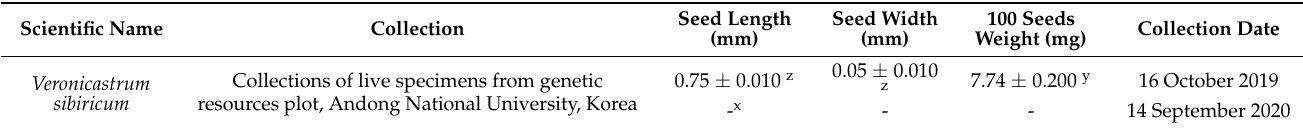
Table 1. Seed collection conditions and basic characteristics of V. sibiricum .